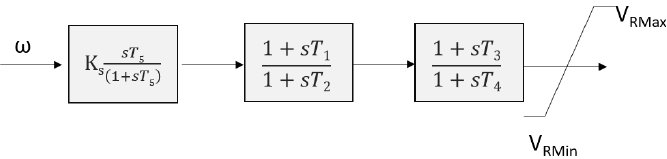
Figure A3. IEEE Figure A3. IEEE PSS1A. Figure A3. IEEE PSS1A. Figure A3. IEEE PSS1A.